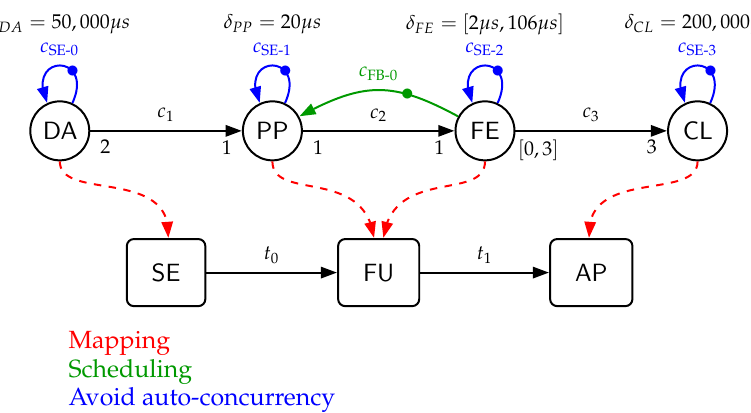
Figure 7. Example CSDF, including mapping and